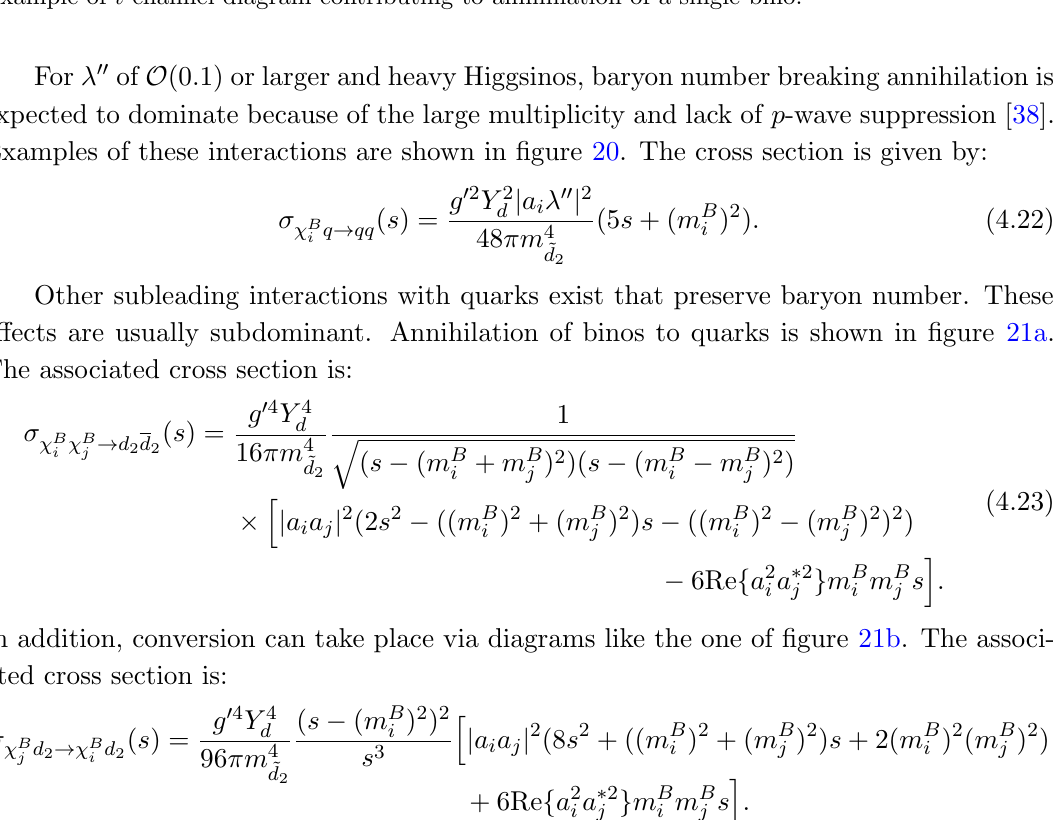
Figure 20. (a) Example of s -channel diagram contributing to annihilation of a single bino. (b) Example of t -channel diagram contributing to annihilation of a single